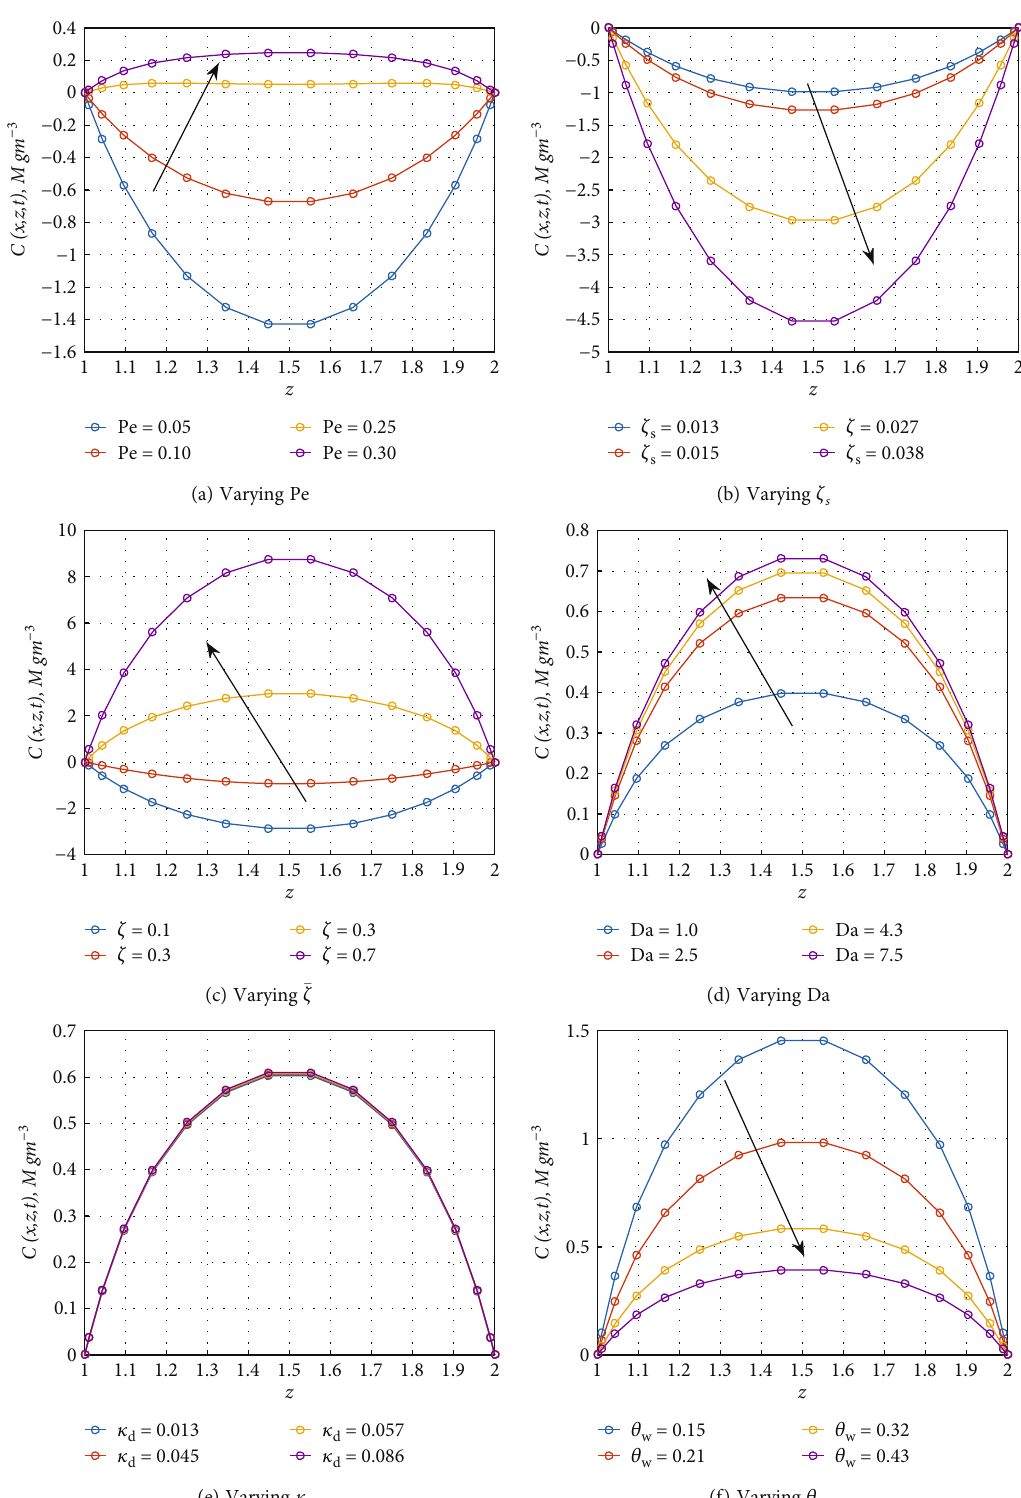
 ζ , , Da , κ , and θ on solute concentration pro fi s d w